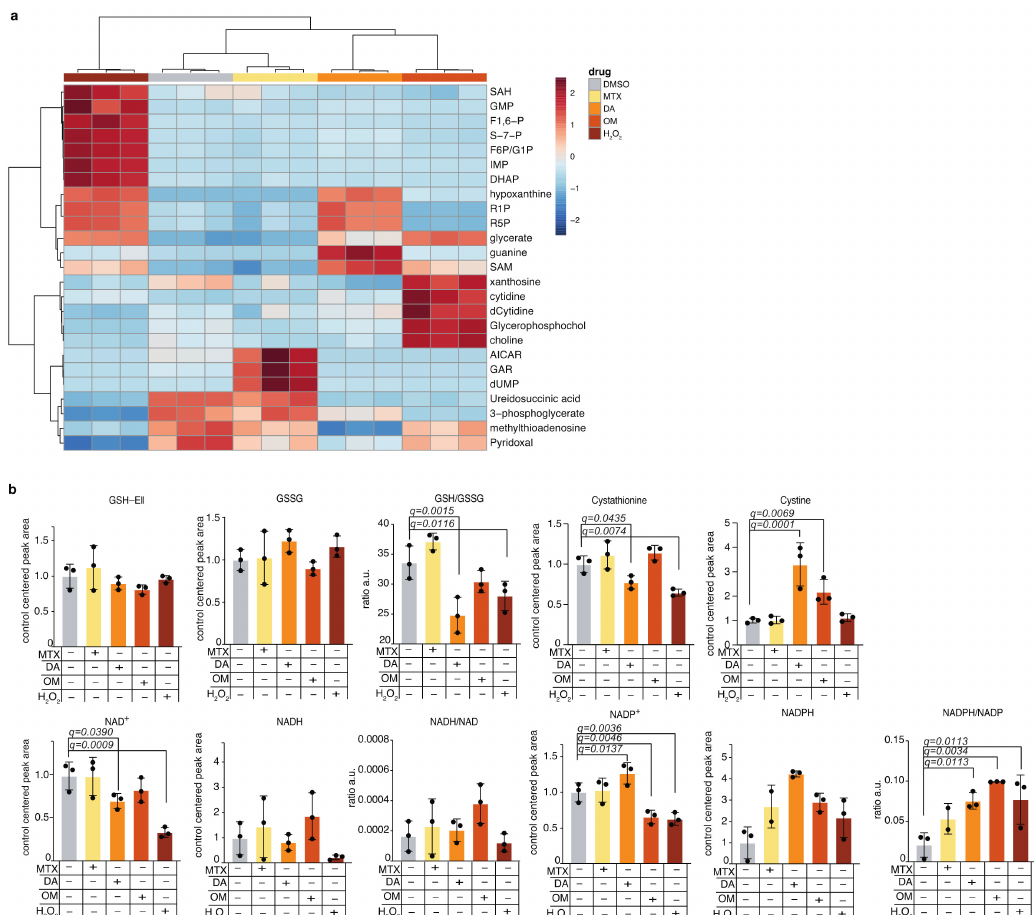
Figure 4. Application of the redox metabolite detection method for profiling redox state following pharmacologic pertur- bations of redox balance in cells; ( a ) K562 cells were treated with drugs that perturb the cellular redox balance and with H 2 O 2 , using the following doses for 4 h: methotrexate: 5 µ M; oligomycin: 80 µ g/mL; H 2 O 2 : 1 mM; diamide: 0.5 mM; DMSO, which served as control: 0.6 µ L per 1mL of cell culture media. The drugs used are diamide (DA), oligomycin (OM), and methotrexate (MTX). Global heatmap analysis of the top 25 differentially-changed polar metabolites is presented; ( b ) Detected levels of redox metabolites in the treated cells. Mean and standard deviation of three technical replicates are presented; statistical significance was determined using Anova with correction for multiple comparisons and false discovery rate. Only significant q-values are